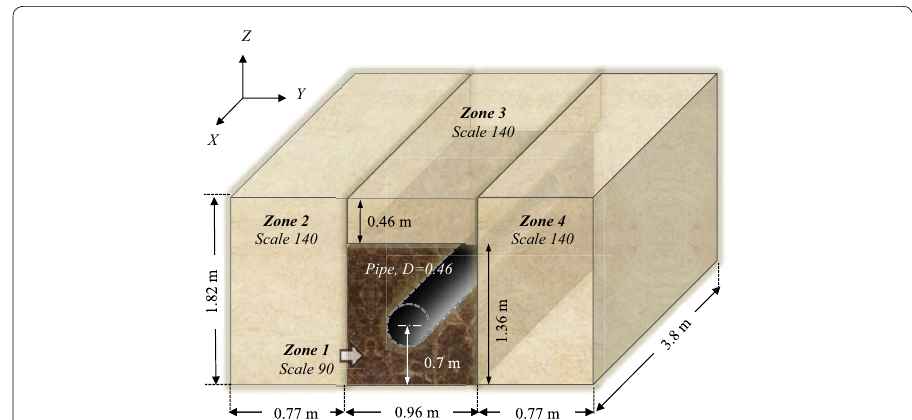
Fig. 2 Different particle size zones used to generate the discrete element